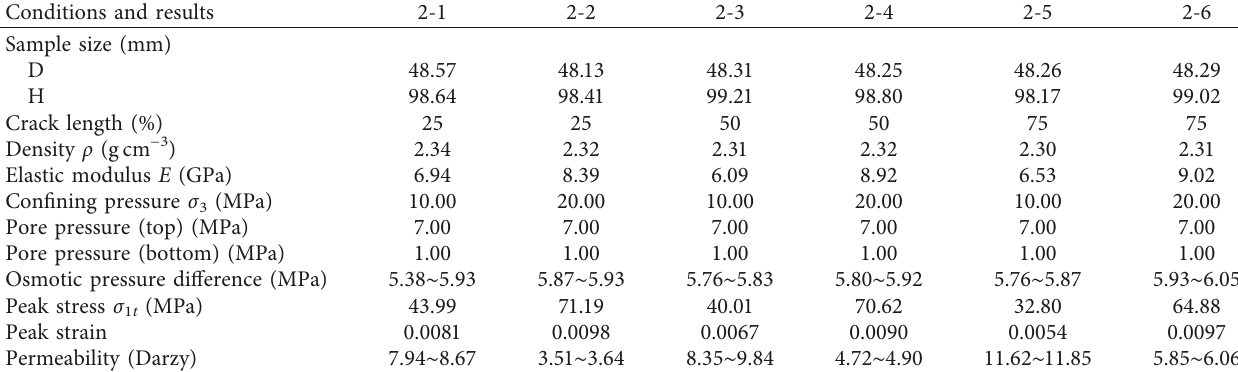
Table 2: Seepage test results of cracked sandstone filled with cement mortar.